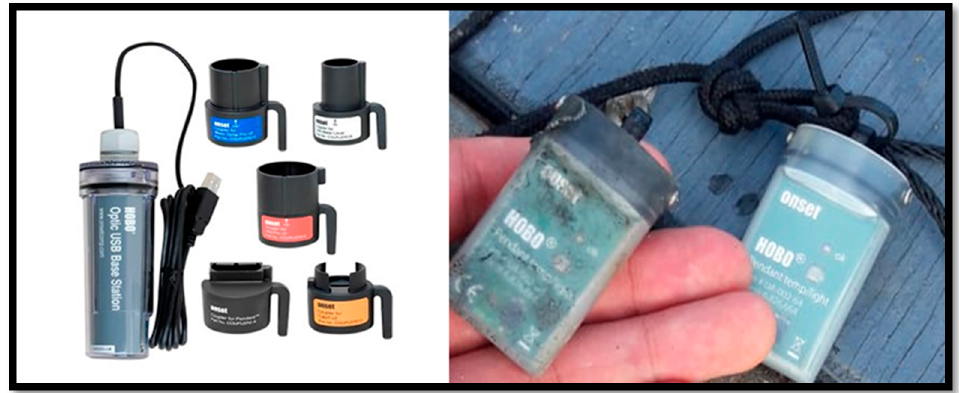
Figure 1. Study areas on the Pacific coast: ( A ) Marina La Cruz de Huanacaxtle and ( B ) La Mina. The black points show where the thermistors were placed.